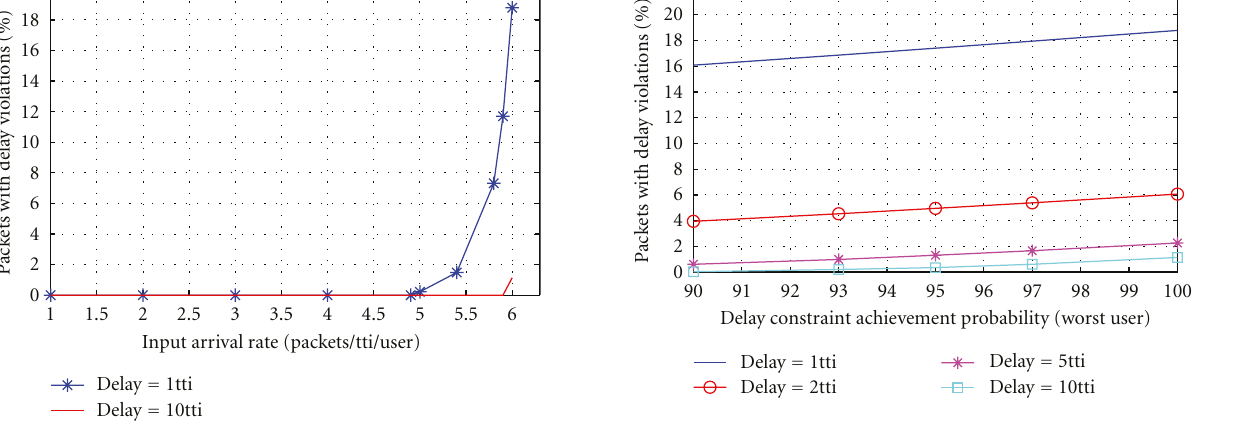
Figure 5: Percentage of packets with delay violations versus input arrival rate for worst user. Users = 14, Subcarriers = 40, Cell Radius = 700m, and tti = 1ms.